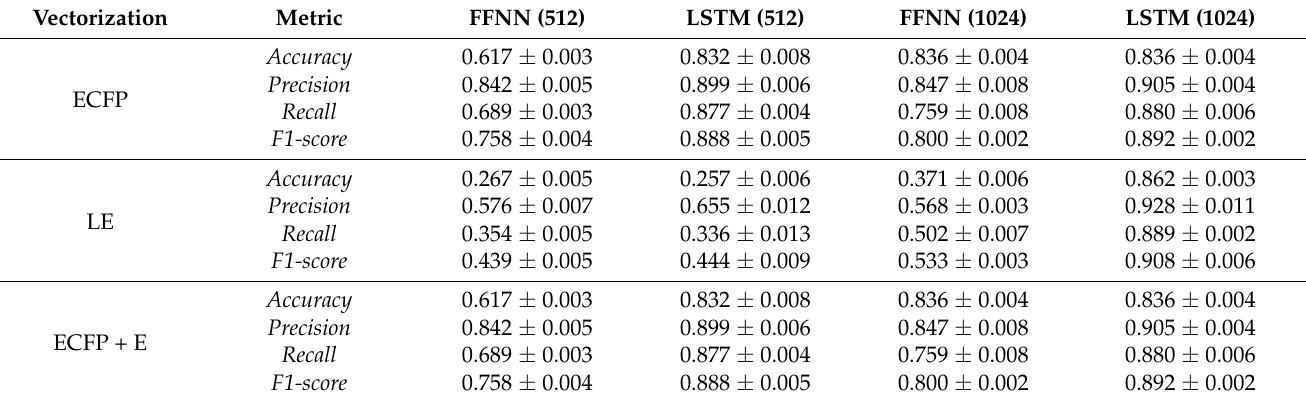
Table 4. Evaluation results on DS1. The lengths of the vectors are presented in parenthesis.